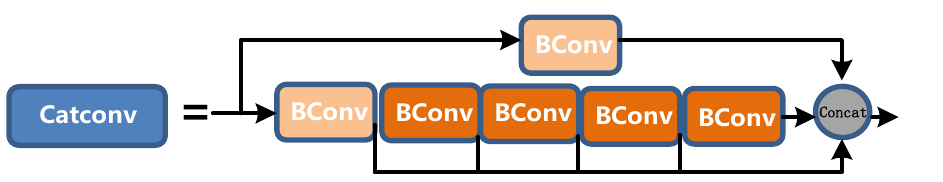
Figure 11. SPPCPC layer diagram.